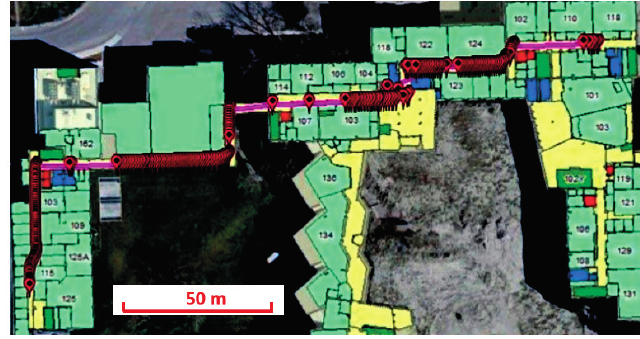
Figure 18. WiFi-aided MM result at ENB.